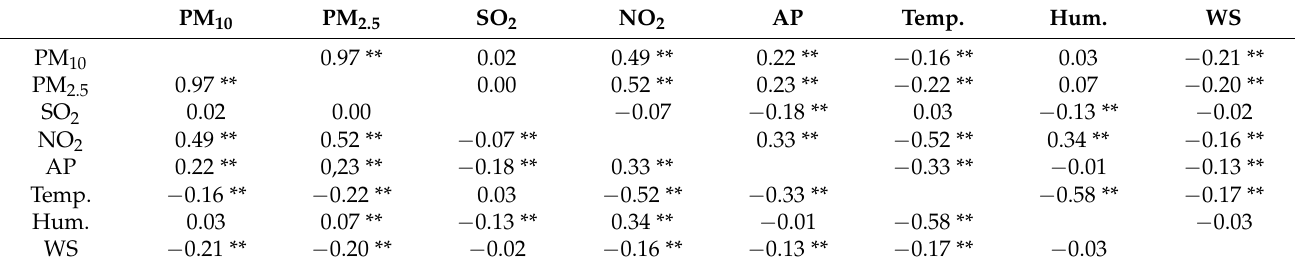
Table 2. Correlation coefficients between air pollutant concentrations and meteorological